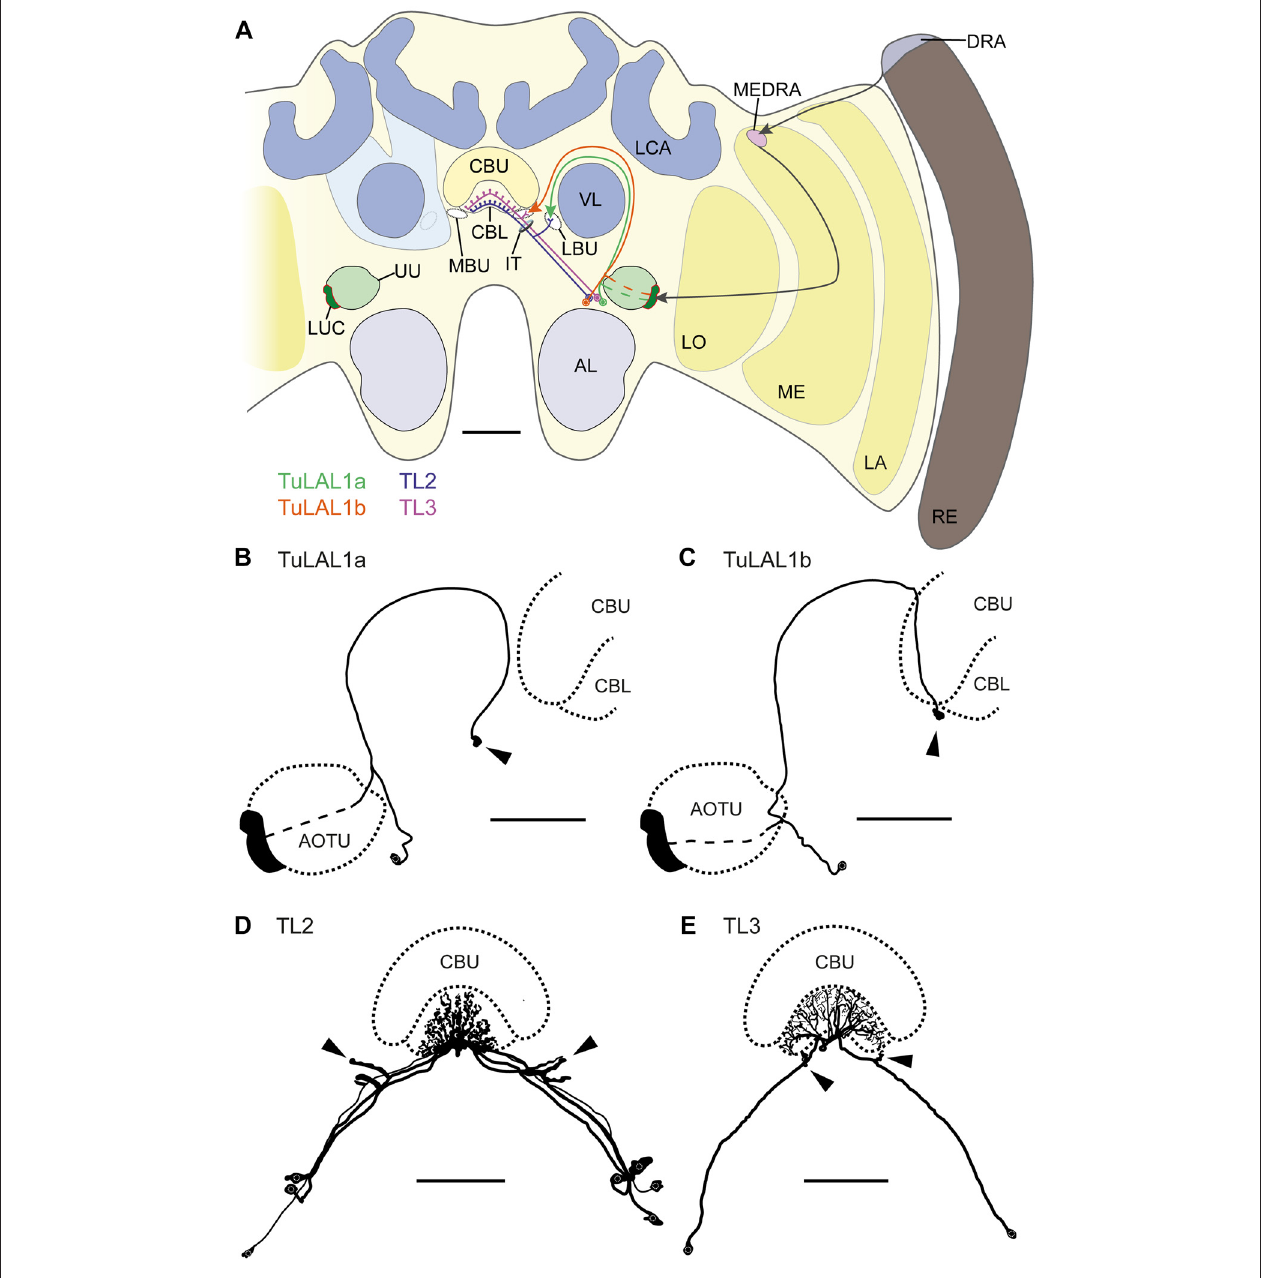
FIGURE 1 | (A) Schematic drawing of the position of the neuron types forming microglomerular synaptic complexes in the medial and lateral bulbs of the honeybee Apis mellifera . The connection from the anterior optic tubercle to the central complex (CX) is formed by tubercle-lateral accessory lobe neurons 1a (TuLAL1a; green) and TuLAL1b neurons (orange). Two types of tangential neuron (TL2, blue; TL3, purple) provide input into the lower division of the central body (CBL). (B–E) Reconstructed morphologies of neurons labeled by extracellular dye injections. TuLAL1a (B) and TuLAL1b (C) neurons have their cell bodies medially from the AOTU. The axons of both types run toward the central body (CB), where they end in large terminals (arrowheads). In TuLAL1a neurons these terminals are located in the LBU ( B , arrowhead), whereas TuLAL1b neurons terminate in the MBU ( C , arrowhead), close to the CBL. TL neurons have their cell bodies medially to the AOTU and posteriorly to the somata of TuLAL1 neurons. Their primary neurites run toward the isthmus tract (IT), where they give off sidebranches. The sidebranches of TL2 neurons extend into the LBU, and those of TL3 to the MBU ( D,E , arrowheads). The axons extend from the bulbs further into the CBL, where they branch in all slices but not in all layers. TL2 neurons branch in the dorsal part of the CBL, TL3 neurons in the ventral part. AL, antennal lobe; CBU, upper division of the CB; DRA, dorsal rim area; LA, lamina; LBU, lateral bulb; LCA, lateral calyx; LO, lobula; LUC, lower unit complex of the AOTU; MBU, medial bulb; ME, medulla; MEDRA, dorsal rim area of the medulla; RE, retina; UU, upper unit of the AOTU; VL, vertical lobe. Scale bars: A = 200 µ m, B–E = 100 µ m.